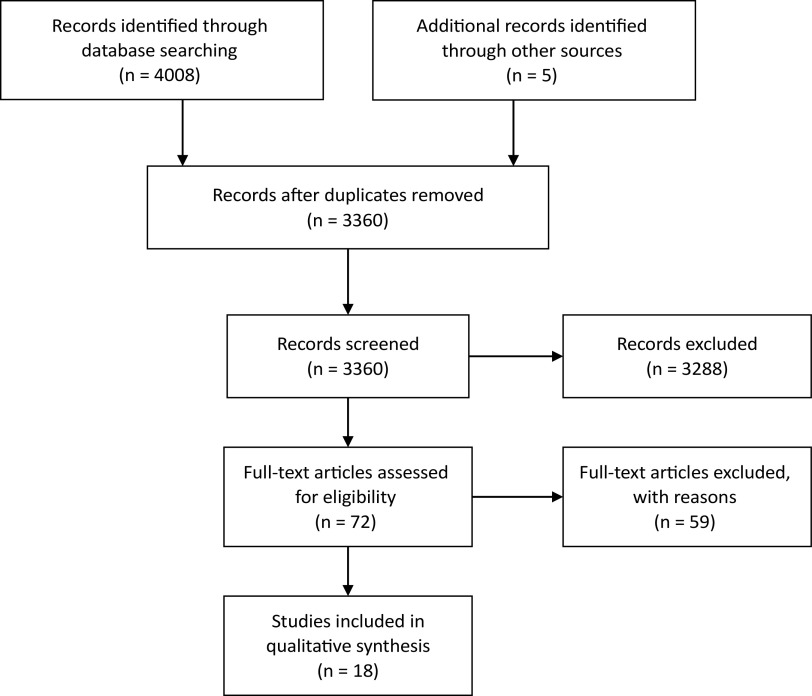
Study flow diagram.